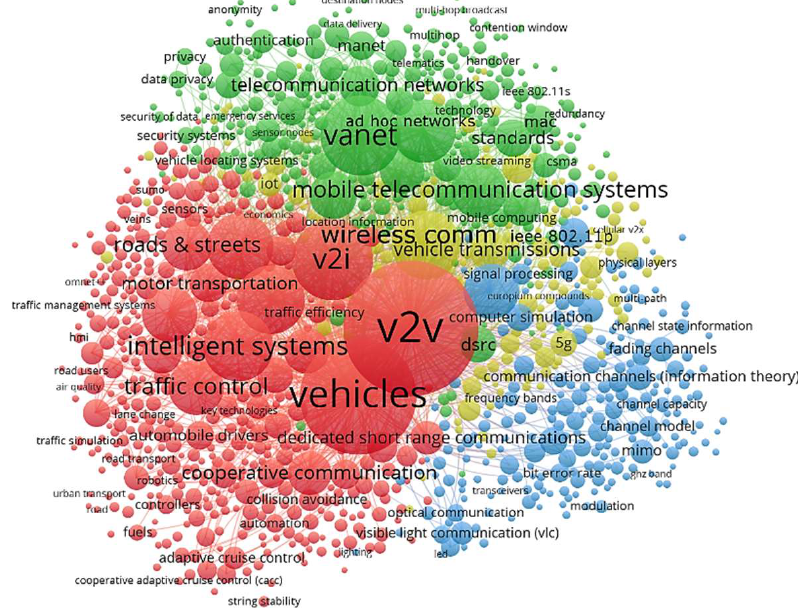
Figure 8. Co-occurrence of the keywords in publications on I2X, V2X, and P2X from 1996 to 2018.